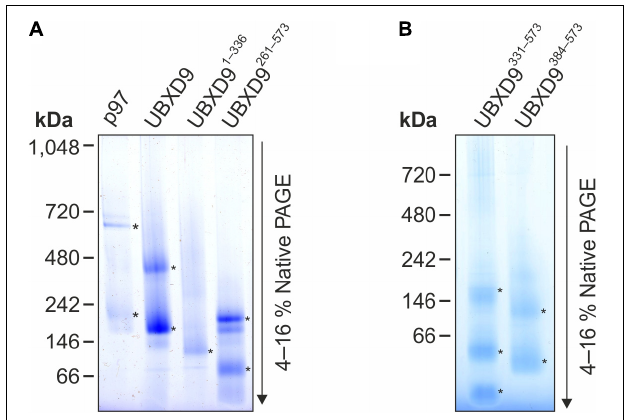
FIGURE 5 | Blue Native PAGE analysis of p97, full-length UBXD9 as well as UBXD9 truncation constructs. Representative Blue Native PAGE gels of purified recombinant non-tagged D. discoideum proteins. Specific bands are marked by asterisks. (A) p97, UBXD9, UBXD9 1 − 336 and UBXD9 261 − 573 .